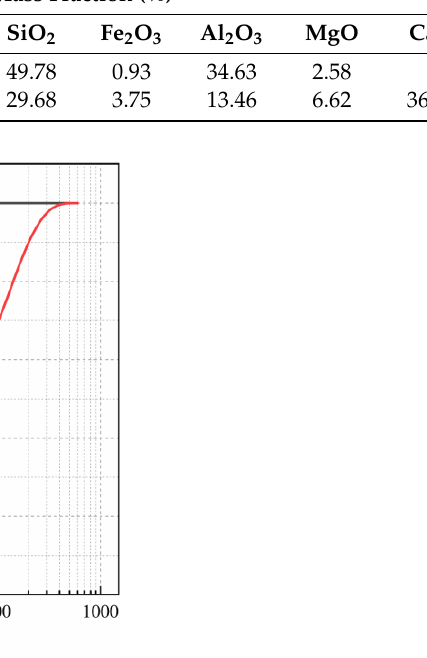
Table 1. Chemical composition of the metakaolin and slag used in this study.